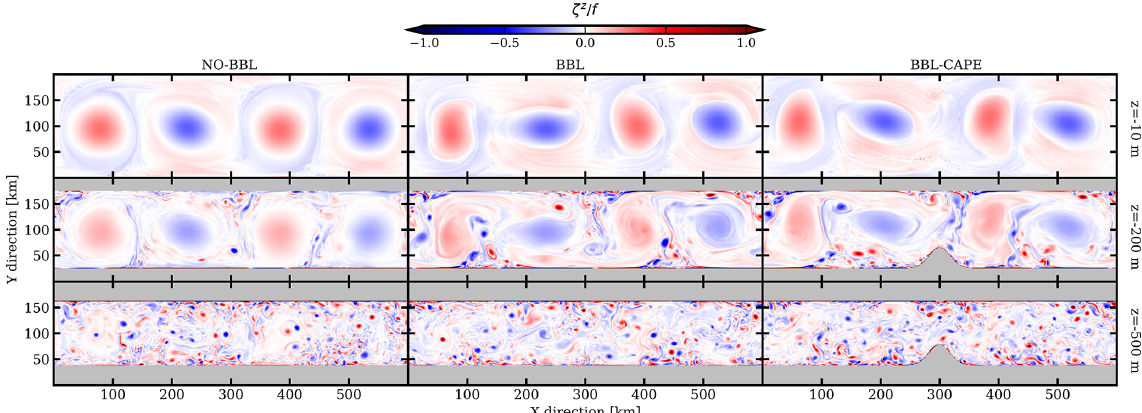
Figure 3. Vertical relative vorticity field normalized by the Coriolis frequency at day 200 and 10, 200 and 500m depth for the NO-BBL, BBL and BBL-CAPE experiments.